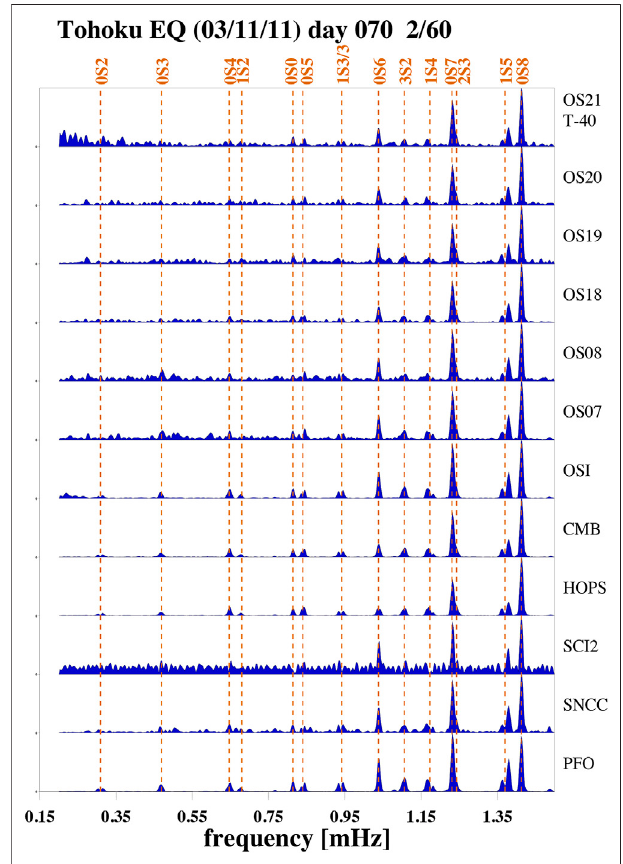
FIGURE 14 | Normalized raw vertical-component spectra for the March 11, 2011 Tohoku, Japan earthquake of 60-hour long segments, starting 2 h after the event time. The bottom six spectra are from permanent land stations (see 15), while the top six spectra are for ALBACORE OBS sites. Site OS21 featured a Nanometrics Trillium T-40 wideband sensor. See online supplement for the spectra of all broadband OBSs.